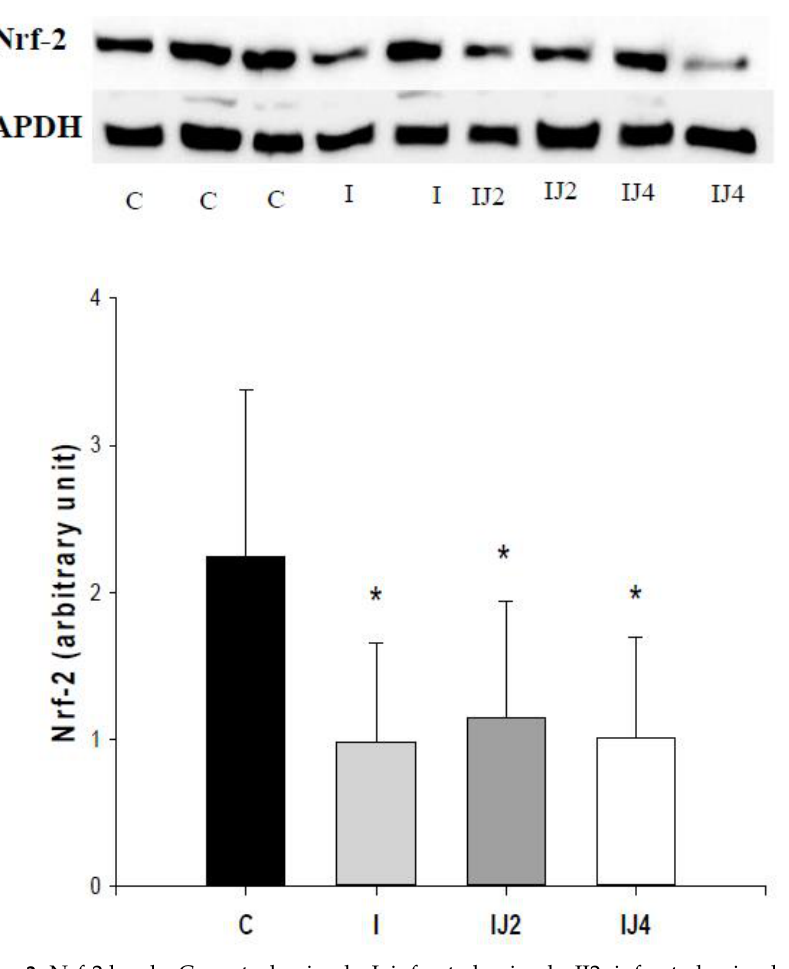
Figure 3. Nrf-2 levels. C: control animals; I: infarcted animals; IJ2: infarcted animals supplemented with jaboticaba 2%; IJ4: infarcted animals supplemented with jaboticaba 4%. * p < 0.05 versus C.